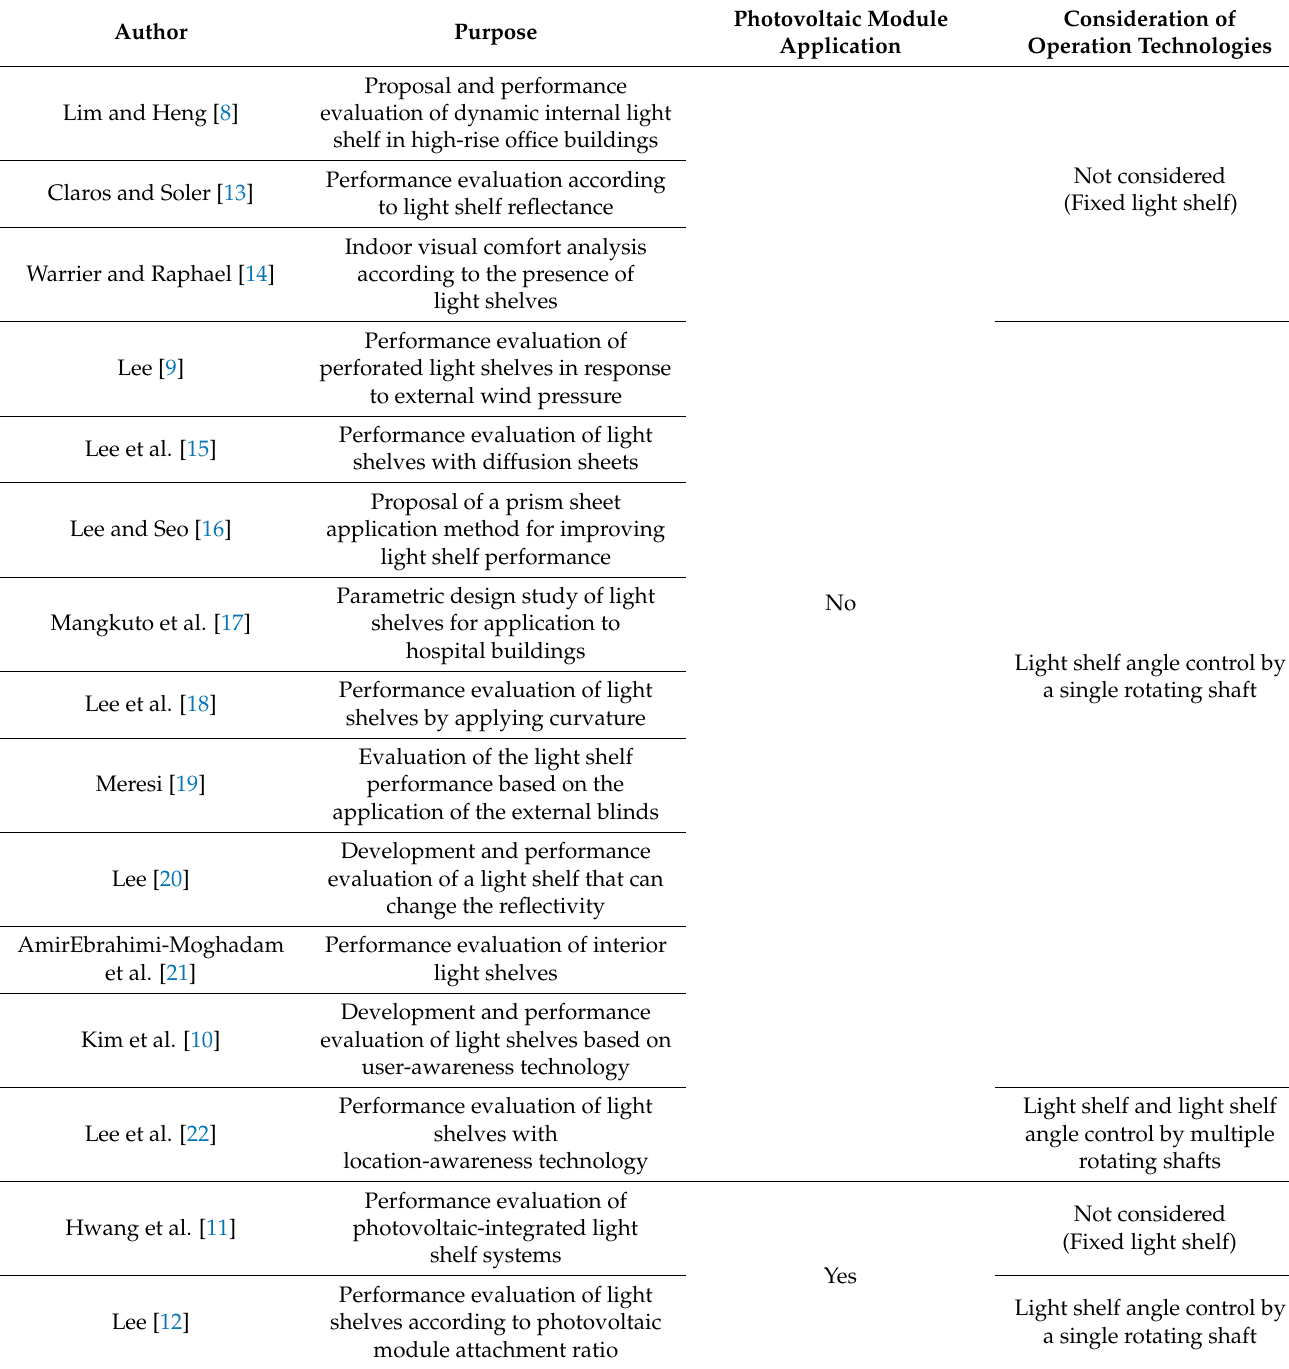
Table 1. Previous studies on light